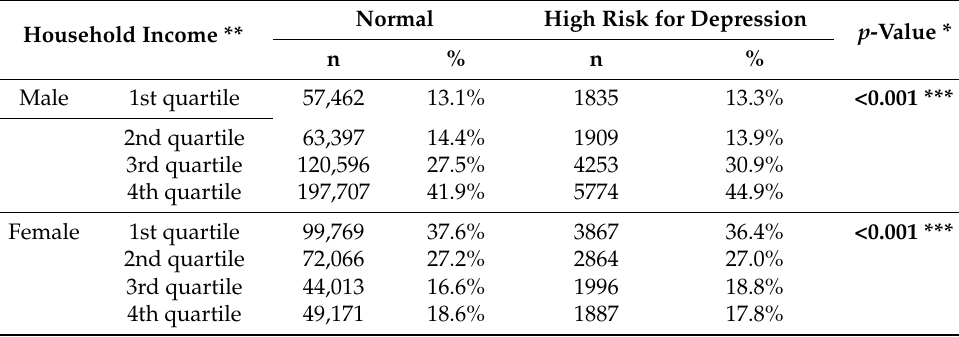
Table 3. Distribution of income level by gender according to PHQ-9 scores. Household Income